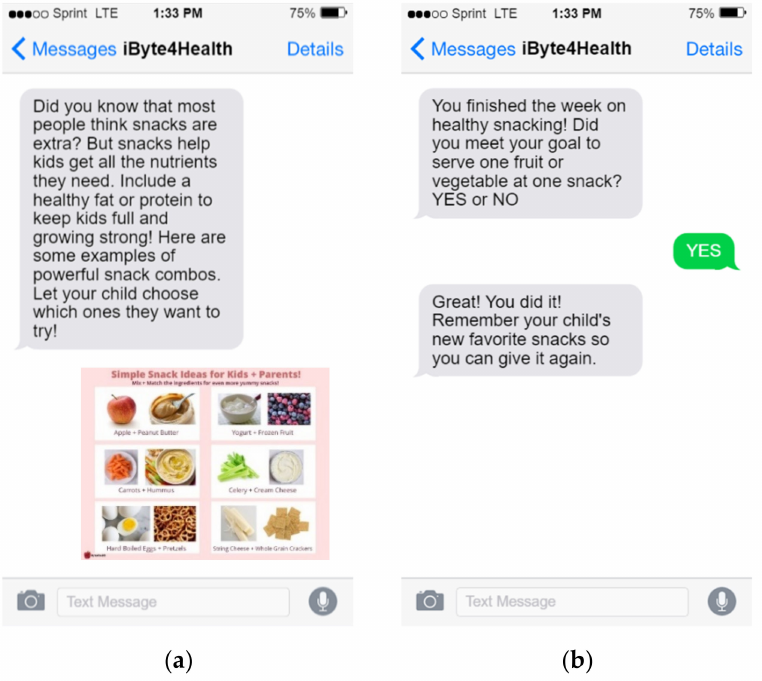
Figure 1. Screenshots of iByte4Health text message content. ( a ) Example of a daily messages with a visual guide; ( b ) Example of a summative self-monitoring text message at the end of the week and a tailored response.